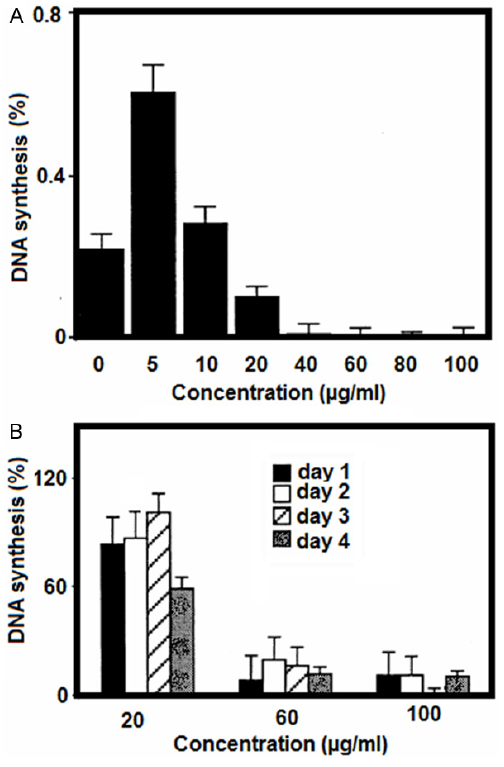
Figure 3. Regulation of DNA synthesis by glycitein in SKBR-3 cells. Cultured cells were treated with glycit- ein at the concentrations indicated for (A) 4 days or (B) the period of time indicated, and the DNA synthe- sis was determined. Values are means ± SD. sons of each individual glycitein concentration versus control